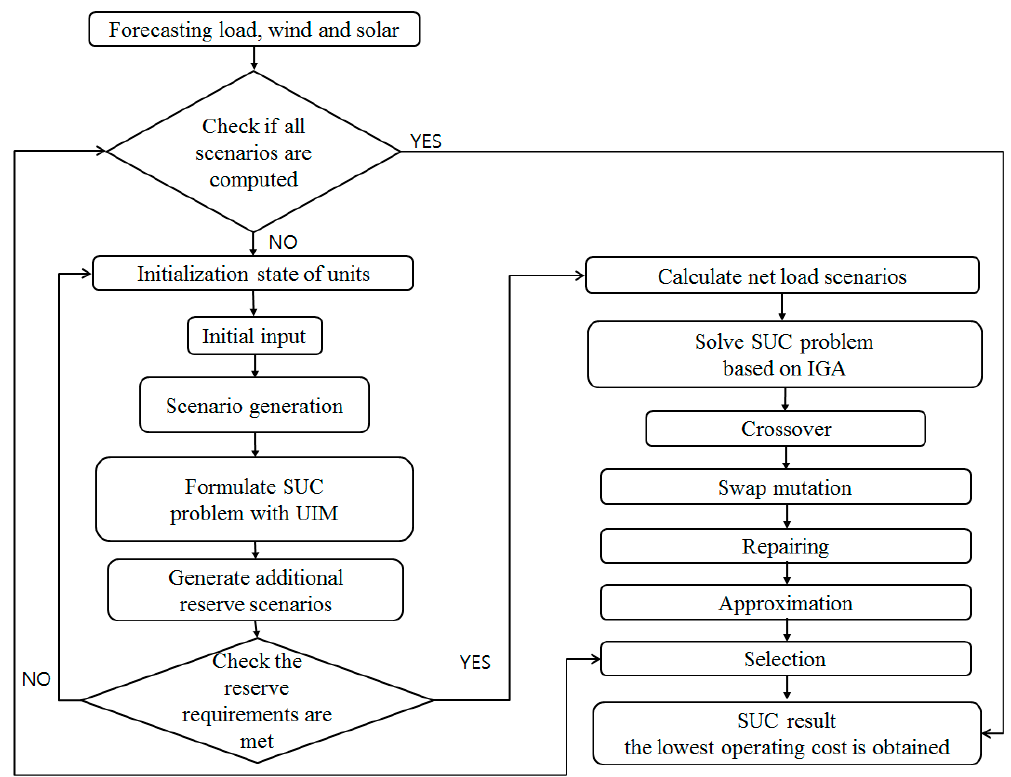
Figure 5. Solution process of improved genetic algorithm (IGA)-based stochastic unit commitment (SUC) problem.